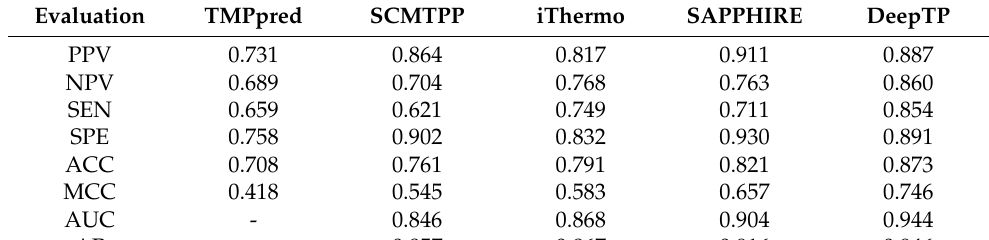
Table 2. Performance comparison of different methods in the independent balanced test set.